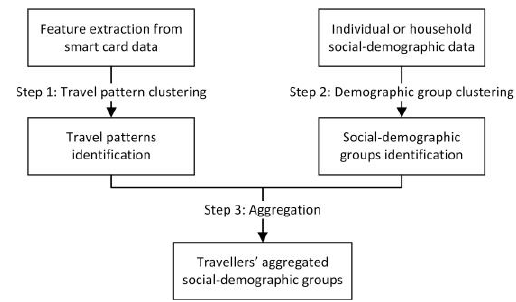
Figure 1. Methodology